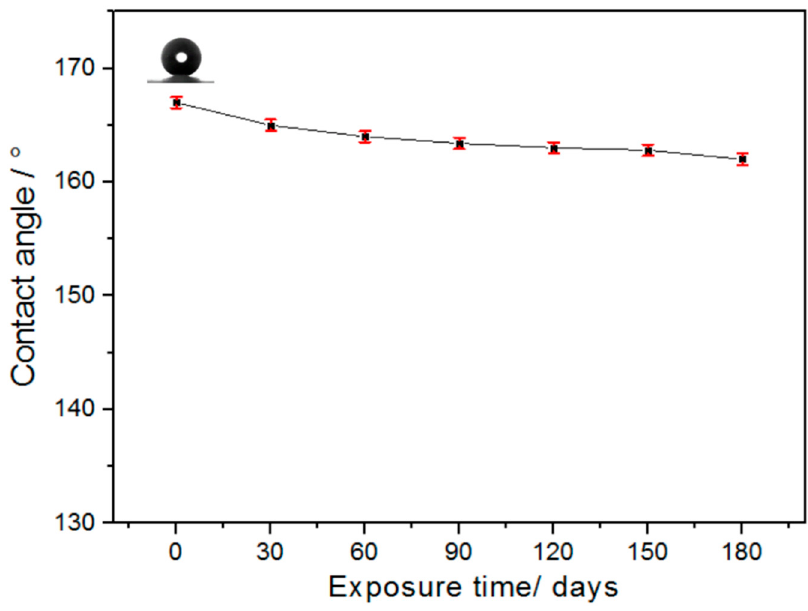
Figure 5. The contact angle (CA) of the target films as the function of different exposure time.